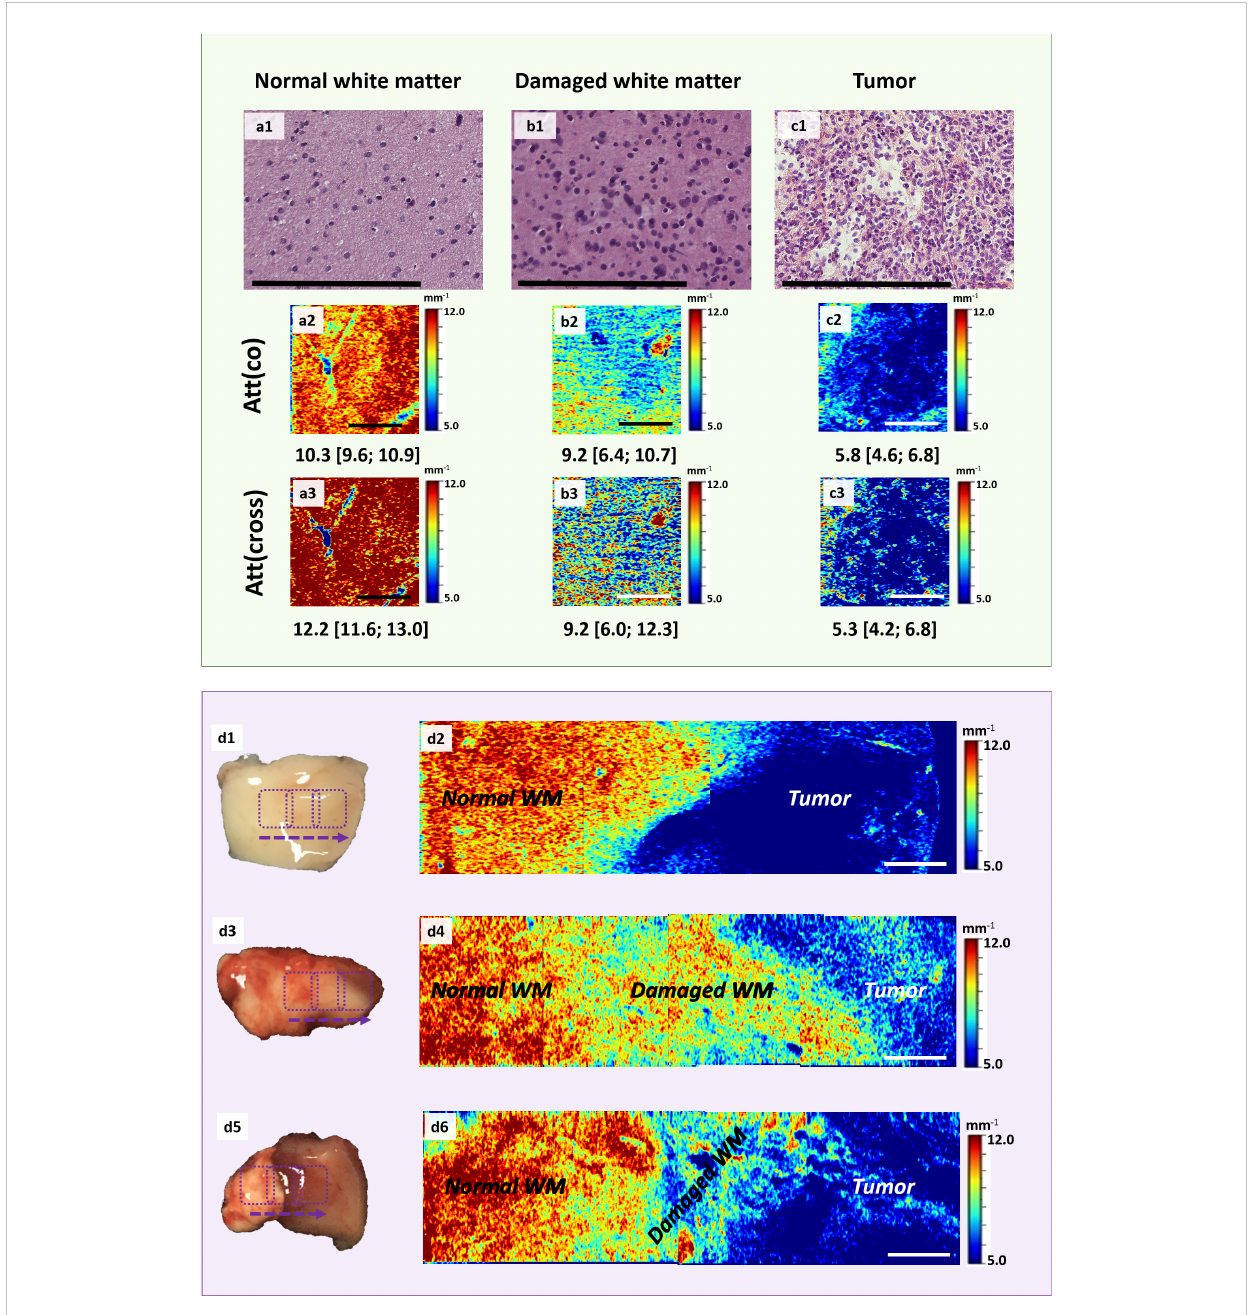
FIGURE 5 Application of color-coded maps for brain tissue visualization. Examples of en-face color-coded maps built based on the Att(co) (a2, b2, c2) and Att (cross) (a3, b3, c3) values distributions for all the studied tissue types with corresponding histology in H&E staining (a1, b1, c1) . (d2, d4, d6) – color- coded map of Att(co) representing different examples of tumor border where the areas of damaged and normal white matter can be visualized. The border between normal white matter and tumor may vary from a narrow strip of damaged white matter (d2) to a broad zone with smaller (d4) or bigger (d6) amount of altered myelinated fi bers. The area of scanning is marked on the sample (d1, d3, d5) using purple rectangles. Scale bar = 200 µm on histological image and 1 mm on OCT